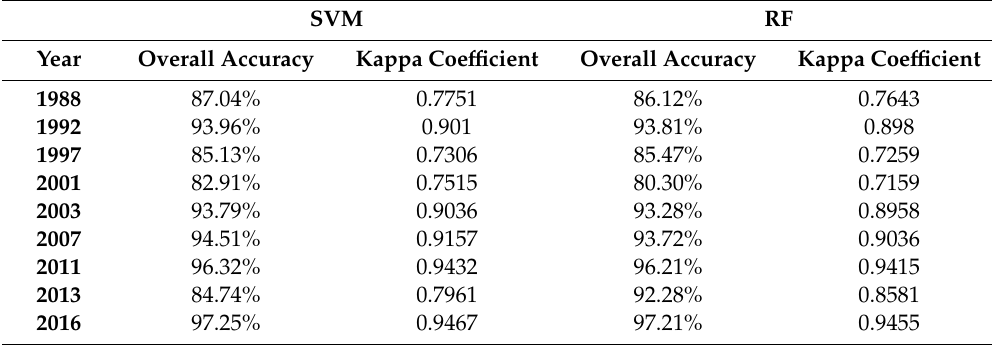
Table 2. Overall accuracy and Kappa coe ffi cient of the